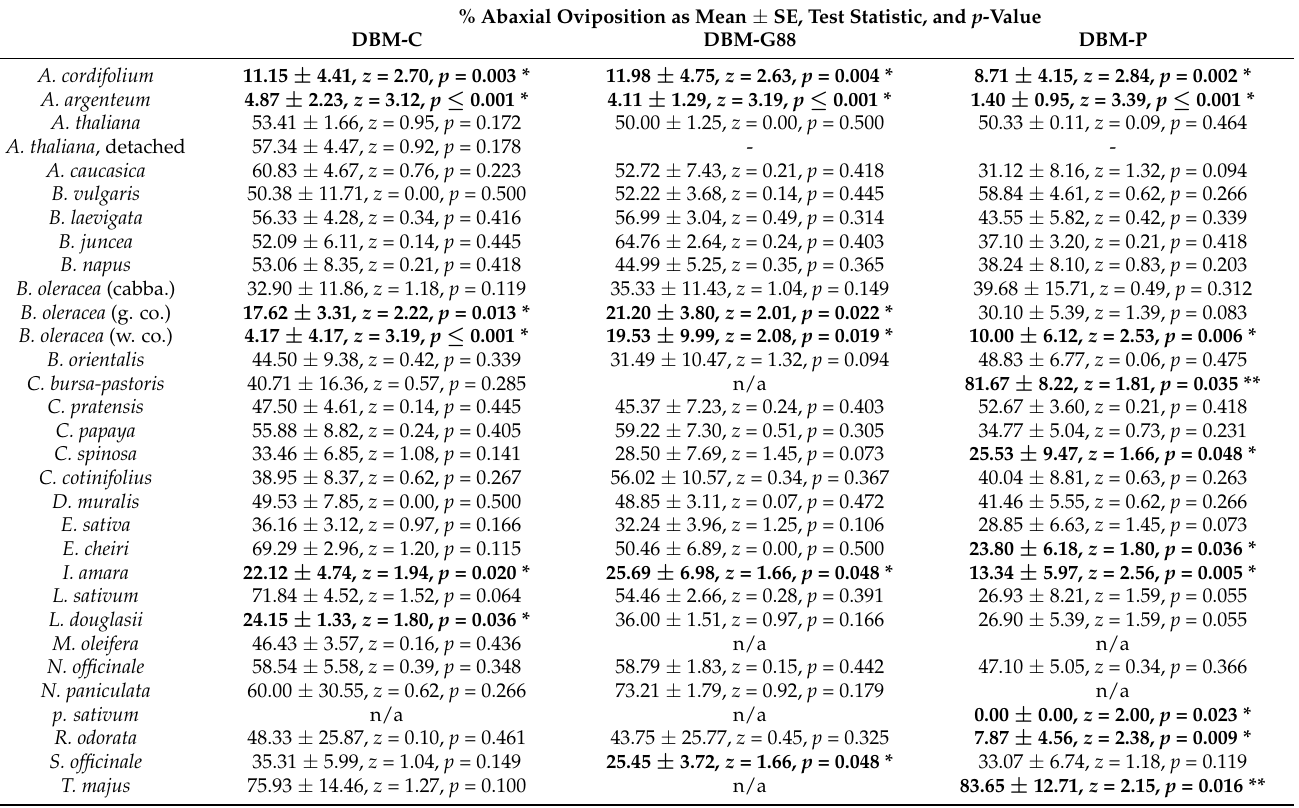
Table 2. Two-choice preference between abaxial and adaxial leaf surfaces shown as the percentage of eggs laid abaxially (mean ± SE) in each of the tested plants in three P. xylostella strains reared on cabbage (DBM-C), artificial diet (DBM-G88), and pea (DBM-P). Data on the differences between the percentages of eggs laid abaxially and adaxially were analyzed using a one-tailed, two-sample test of proportions ( p ≤ 0.05). The test compared the percentages of eggs laid abaxially and adaxially for each plant type and P. xylostella strain (n = 3–96, except in the case of C. papaya and M. oleifera , and for DBM-C, N. paniculata for DBM-G88, and R. odorata for DBM-P in which n = 2). Significant p -values are shown in bold type. The experiment with detached leaves of A. thaliana is shown as “ A. thaliana ,